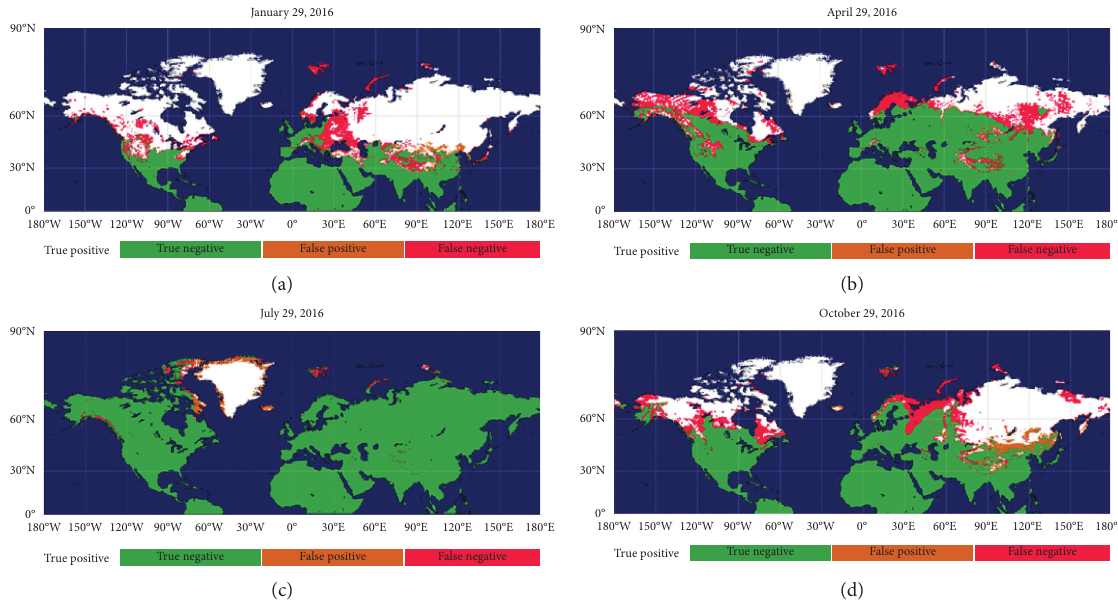
Figure 5: MIRS vs IMS maps showing the classifications of the comparison on 29th of January, April, July, and October of 2016, respectively. Red areas show where MIRS misses snow or underestimates snow false classification, is lower due to low snow cover present. MSPPS during the study period.